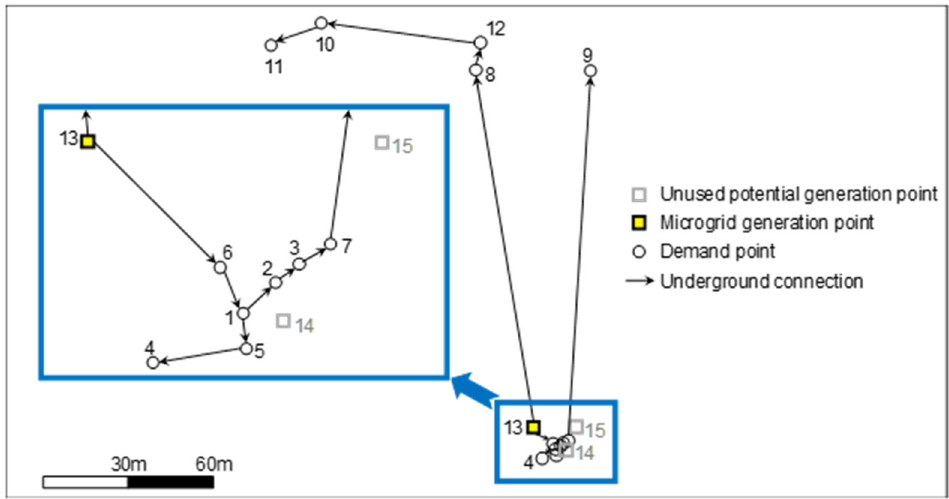
Figure 7. Microgrid obtained for Suraka.